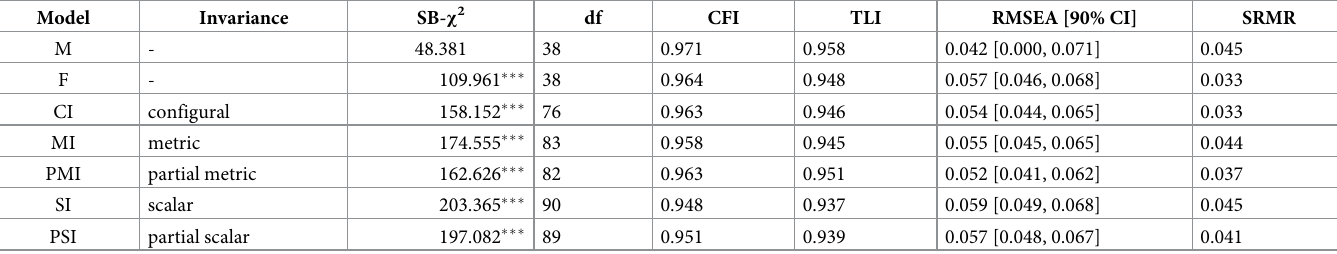
Table 4. Model fit for invariance models.